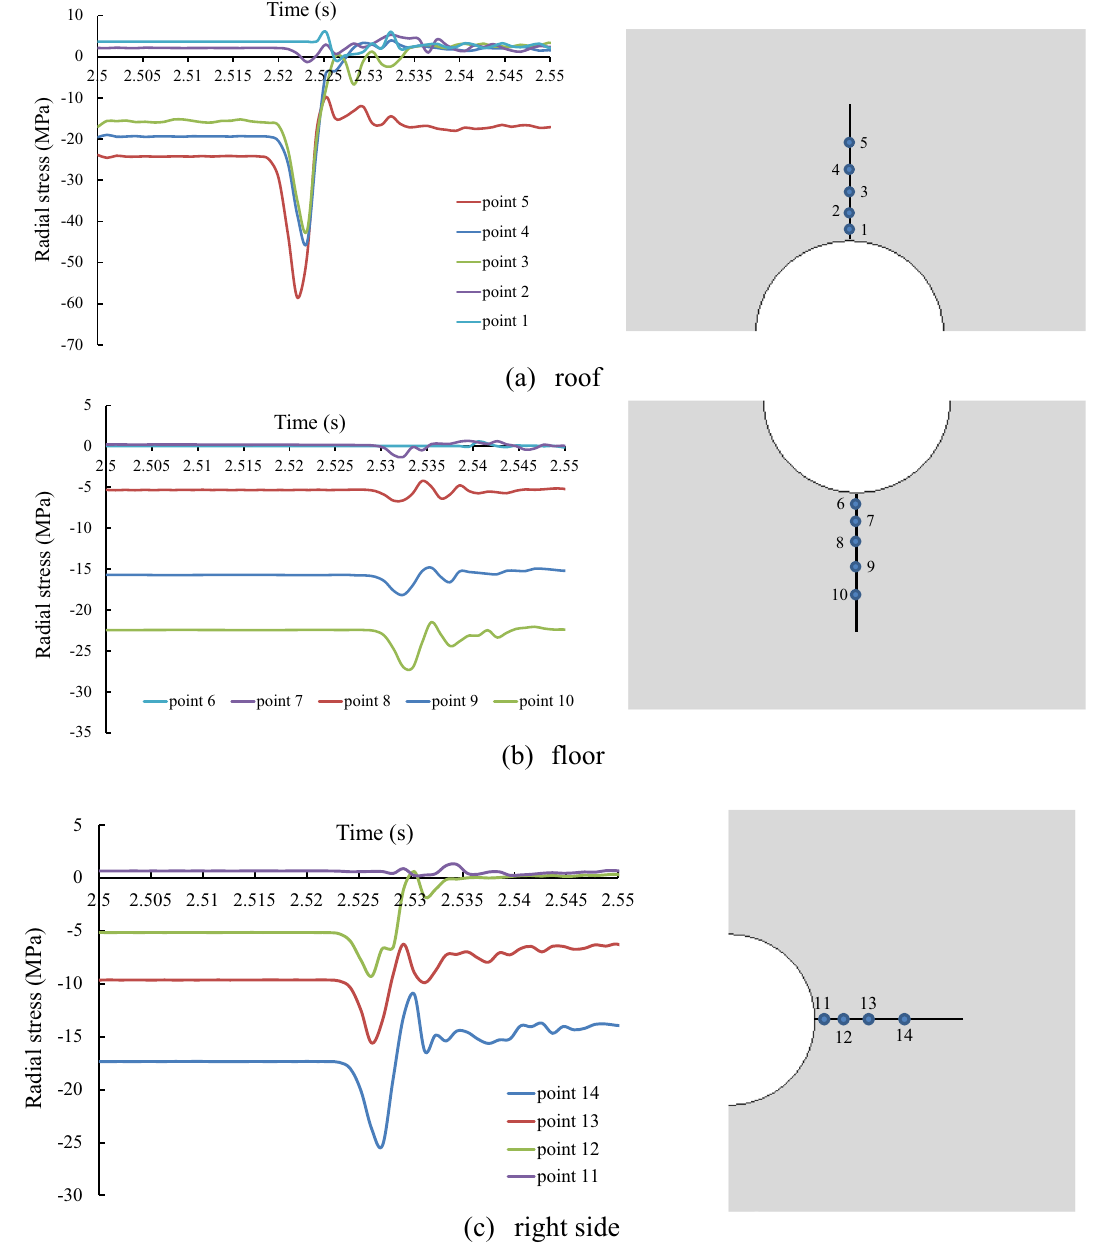
Fig. 7 Radial stress-time evolution curves for corresponding monitoring points in different locations of cavern. Note: the negative value indicates that the rock is subjected to compressive stress